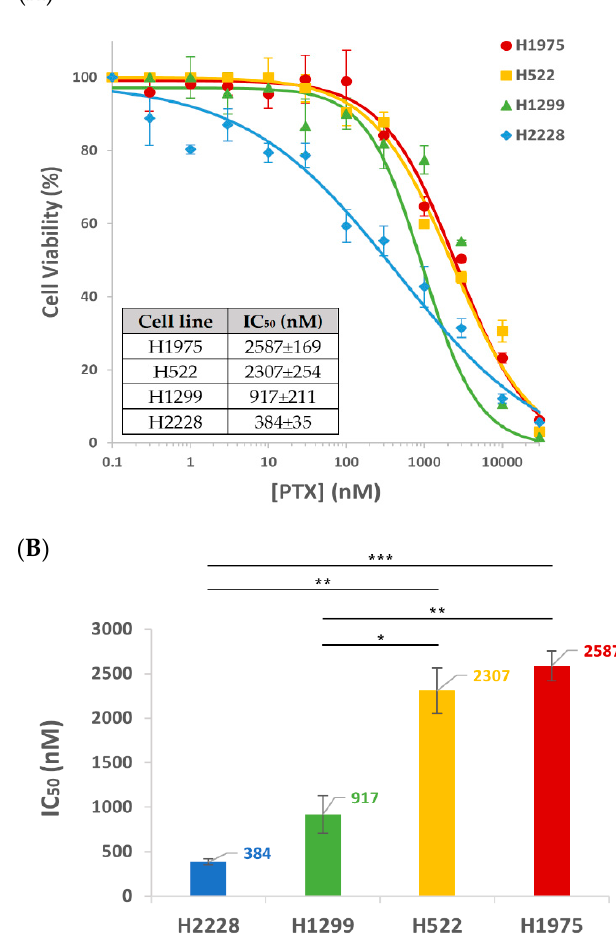
Figure 7. Cytotoxicity of PTX-loaded APT-NPs to various NSCLC cells. ( A ) APT-NPs entrapping PTX were incubated with the NSCLC cell lines H2228, H1299, H522 and H522. Cell viability as a function of the PTX concentration is presented as mean ± SE. ( B ) IC 50 values derived from each appropriate dose-response curve ± SE. P-values obtained were < 0.05 for all cell lines. * p < 0.05, ** p < 0.01, *** p < 0.001, unpaired, two-tailed t -test.